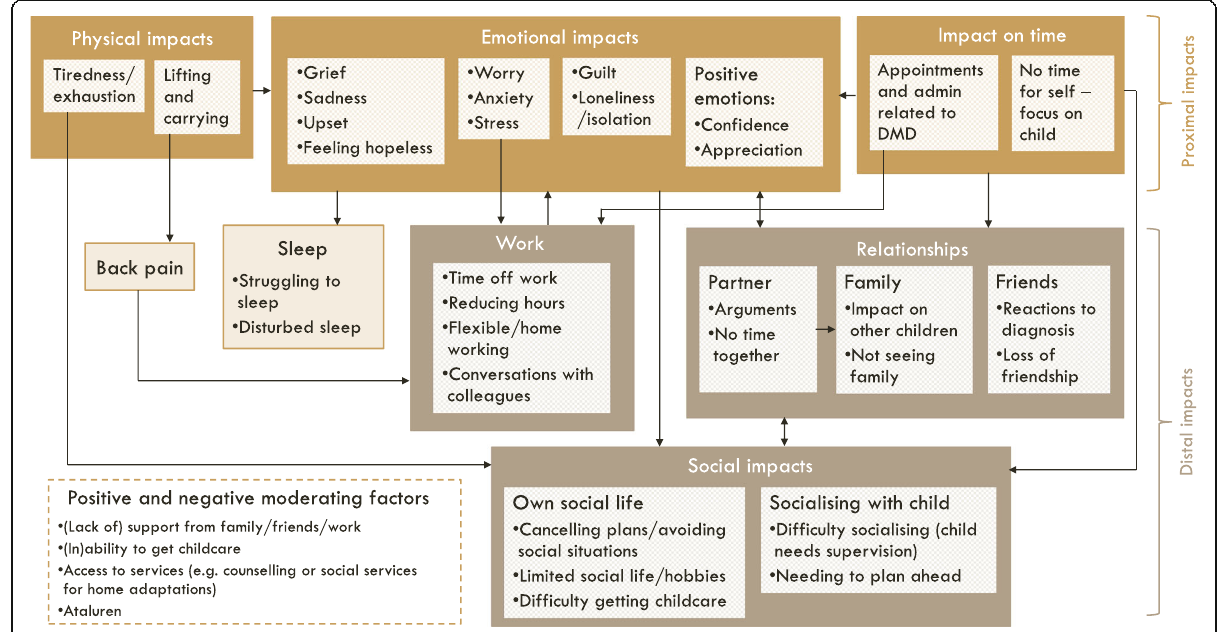
Fig. 1 Conceptual model on the impact of caring for an individual with ambulatory nonsense mutation Duchenne muscular dystrophy Footnote: The conceptual model is designed to be read from the top, where there are the most proximal impacts, to the bottom, where there are more distal impacts. The arrows show the relationships between the concepts, which are either unidirectional (e.g. work had an impact on emotional wellbeing) or bidirectional (e.g. relationships impacted social impacts and vice versa). Some relationships are between the larger external boxes (e.g. emotional impacts had an impact on sleep), whereas others are between the internal boxes (e.g. partner relationships impacted family